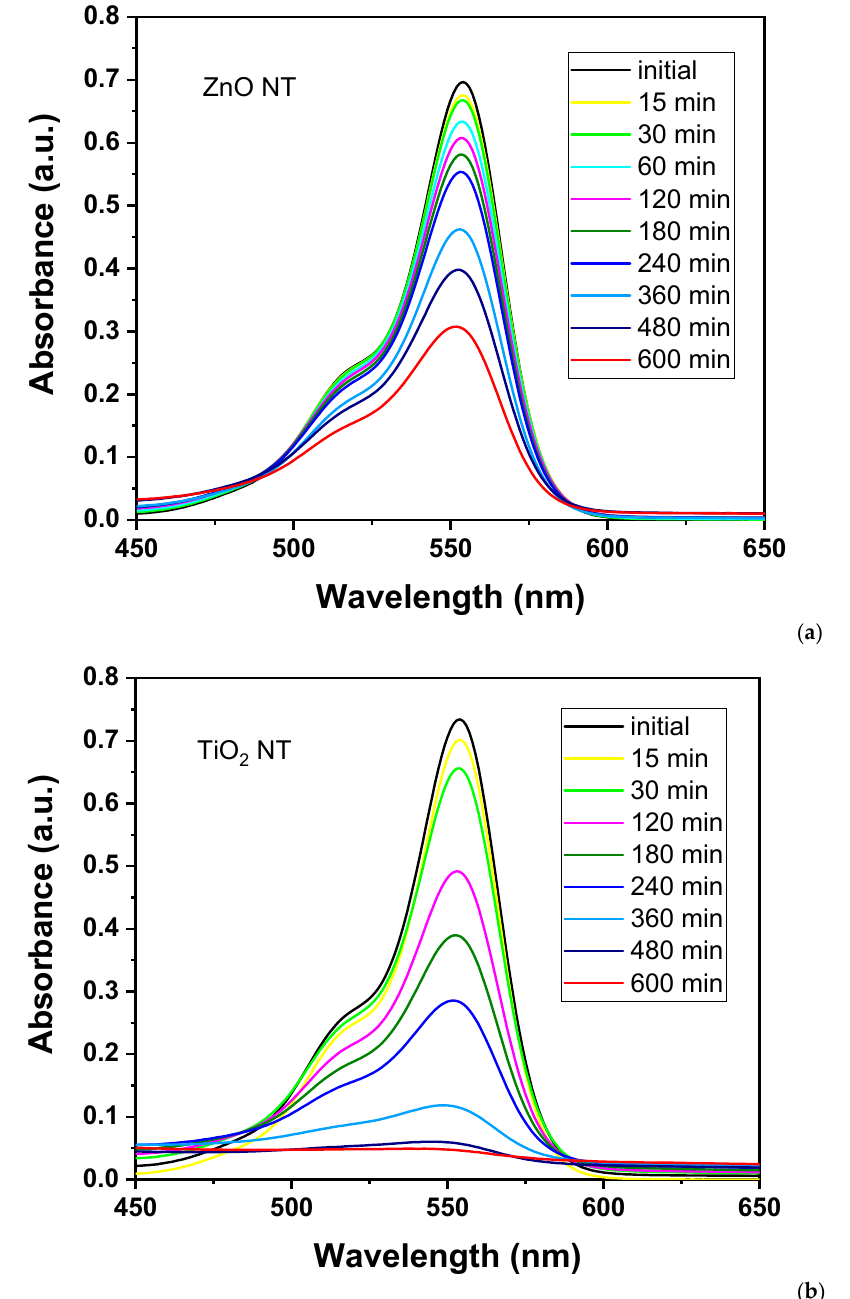
Figure 6. Absorption spectra of RhB solutions after irradiation with white light of a solar simulator for different times in the presence of ( a ) ZnO nanotubes and ( b ) TiO 2 nanotubes.